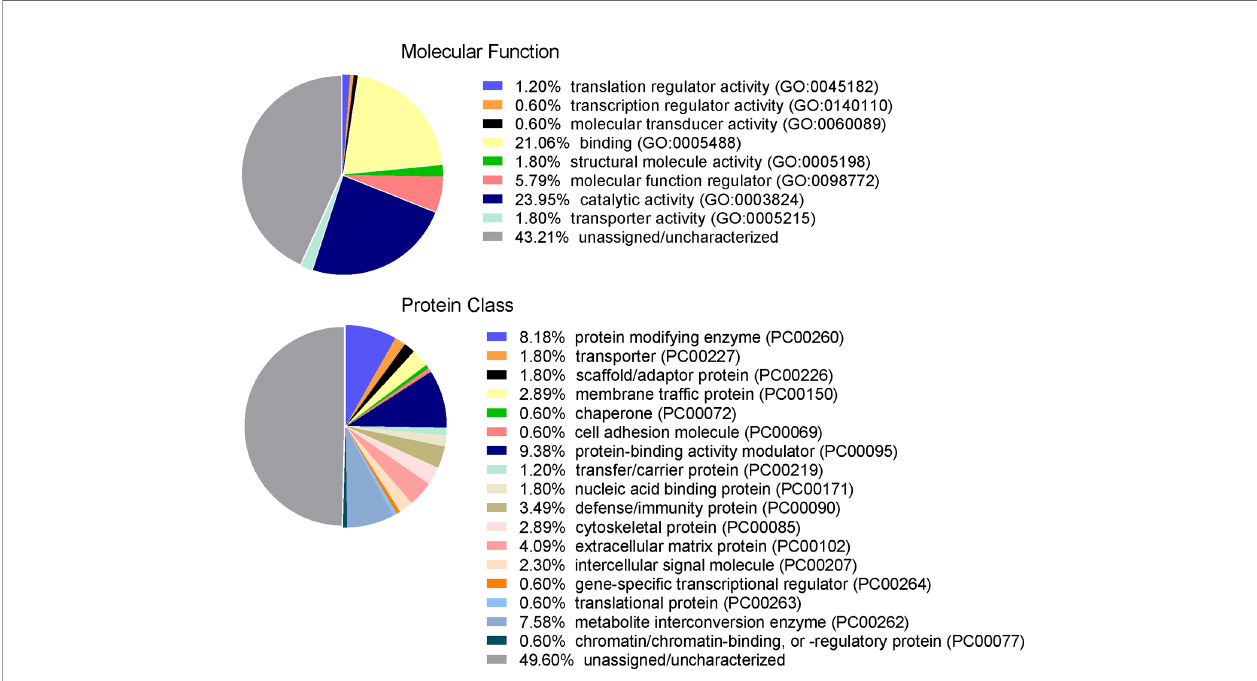
FIGURE 5 | Functional categorization of TV sEV proteome. The identi fi ed TV sEV proteins were sorted into functional groups for molecular function with gene ontology (GO) terms and for protein class (PC) using PANTHER classi fi cation system (pantherdb.org).